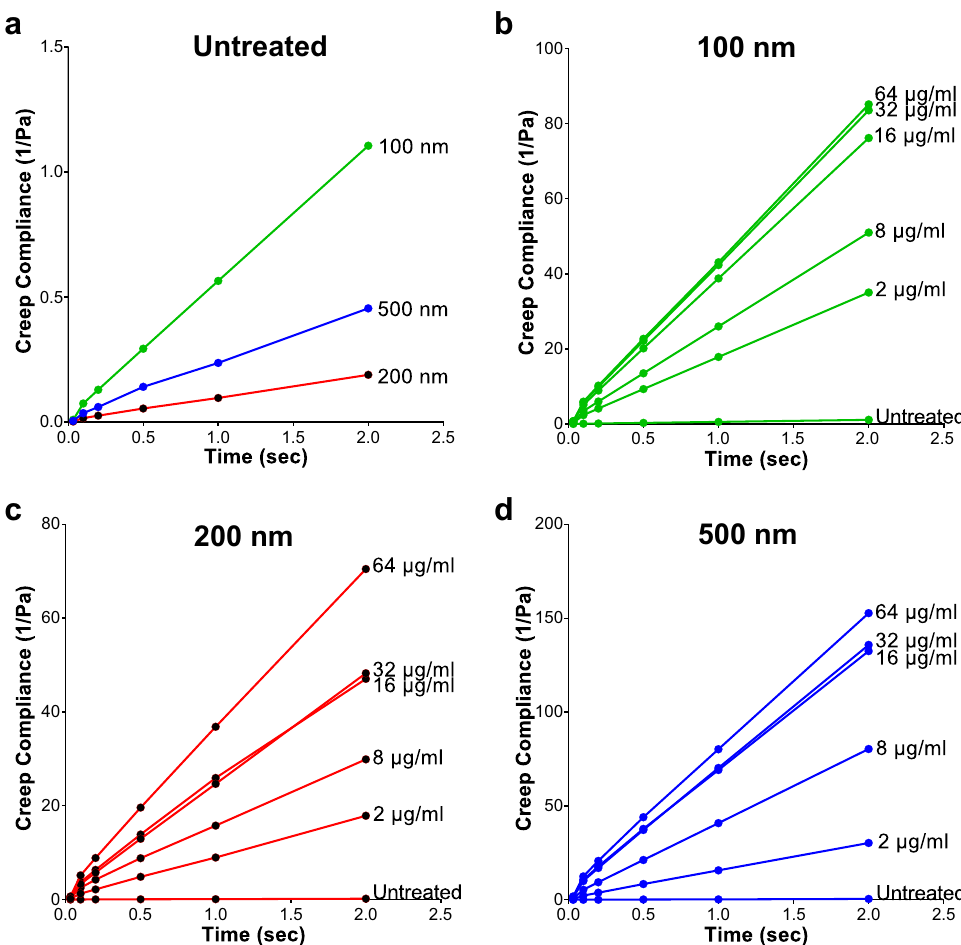
Fig. 5 Creep compliance of E. coli IR57 (PMB Sens ) bio fi lms treated with Polymyxin B. Creep compliance ( J ( t )) of E. coli IR57 (PMB Sens ) bio fi lms (measured using the ensemble mean square displacement <MSD> versus lag time of 100, 200 and 500 nm negatively charged carboxylate- modi fi ed Fluo Sphere ® particles) representing bio fi lm deformation in response to polymyxin B treatment (2, 8, 16, 32 and 64 µg/ml) versus untreated bio fi lm. a Untreated E. coli bio fi lms for 100, 200, and 500 nm Fluo Sphere ® particles, b 100 nm Fluo Sphere ® particles, c 200 nm Fluo Sphere ® particles, and d 500 nm Fluo Sphere ® particles, in response to polymyxin B